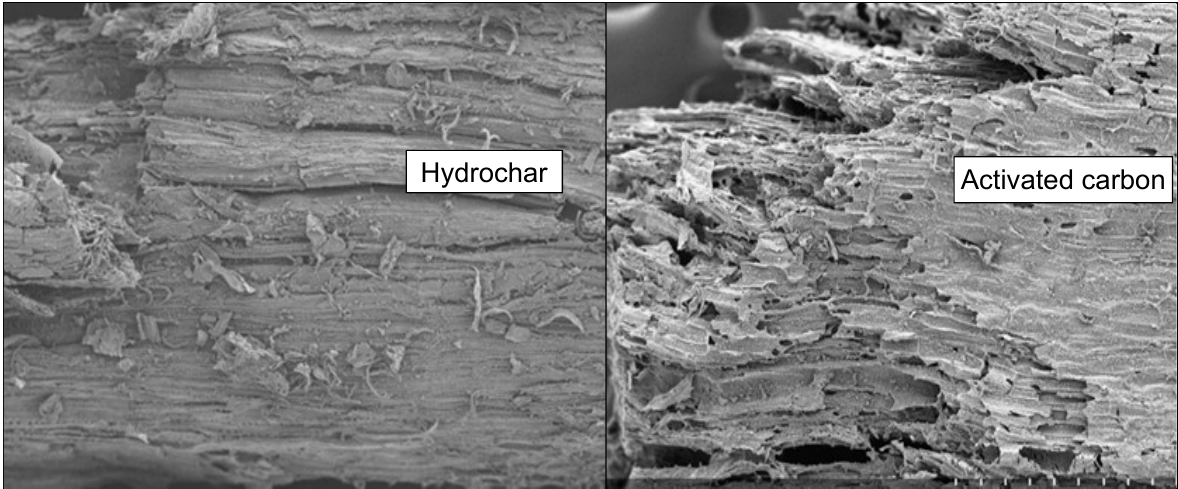
Figure 8. SEM-EDS of hydrochar before activation and activated carbon after activation.